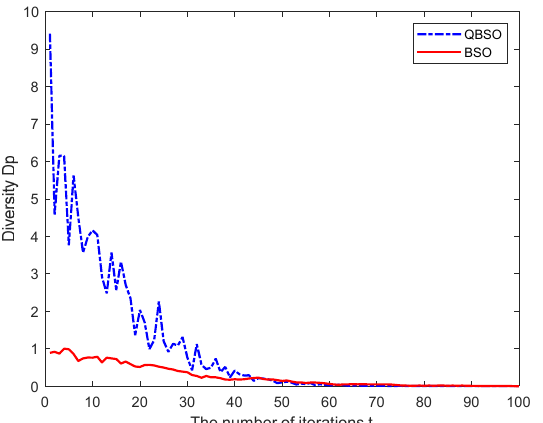
Figure 7. Population diversity at different iterations when optimizing the Griewank function with the population size = 30.